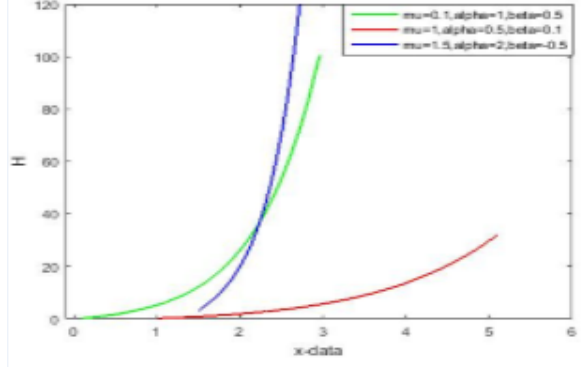
Fig. 4. Plot the Hazard